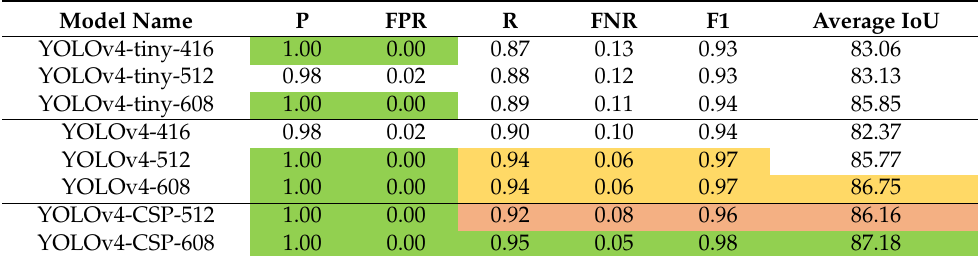
Table 8. Performance metrics of the YOLOv4 models in terms of Precision (P), False Positive Rate (FPR), Recall (R), False Negative Rate (FNR), F1 score and average Intersection-over-Union (IoU) on the test dataset. Ranking is indicated by color, where green is 1st, yellow is 2nd, and orange is 3rd